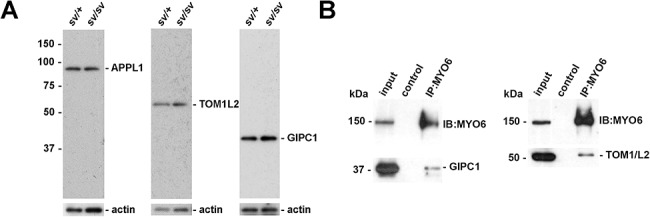
MYO6 forms a complex with TOM1/L2 and GIPC1 in mouse testes. (A) Immunoblotting of tissue extracts from sv/+ and sv/sv testes with anti-APPL1, anti-TOM1/L2, anti-GIPC1, and anti-actin antibodies. Actin is shown as a loading control. No changes in protein expression were observed in sv/sv spermatids in comparison to control cells. (B) Co-immunoprecipitation of MYO6, GIPC1, and TOM1/L2 from sv/+ testes lysates. MYO6 was immunoprecipitated with a rabbit polyclonal antibody. Lysates of sv/sv testes were used in the control lane. The immunoprecipitates were analyzed by western blotting with antibodies to GIPC1 and TOM1/L2.